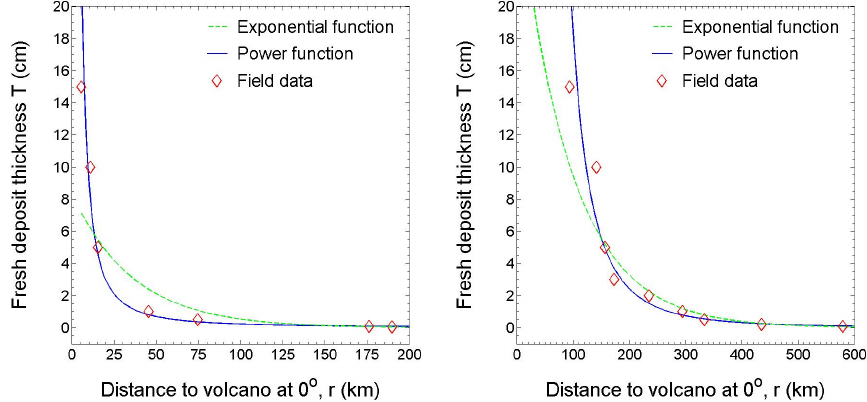
Fig. 5. (a ) Ashfall deposit thickness data for the 30 June 1997 Popocat´epetl eruption along a radial line at 0 ◦ , the wind axis. Field data (diamonds obtained from the isopachs of Martin Del Pozzo et al., 2008), and best fittings to a power function (solid line, C r = − 0 . 989) and to an exponential function (dashed line, C r =− 0 . 960). (b) Ashfall deposit thickness data for the 3 May 2008 Chait´en eruption (Chile), along a radial line directed at 0 ◦ (wind axis). Field data (diamonds obtained from the isopachs of Watt et al., 2009) and best fits to a power function (solid line, C r =− 0 . 988) and to an exponential function (dashed line, C r =− 0 .